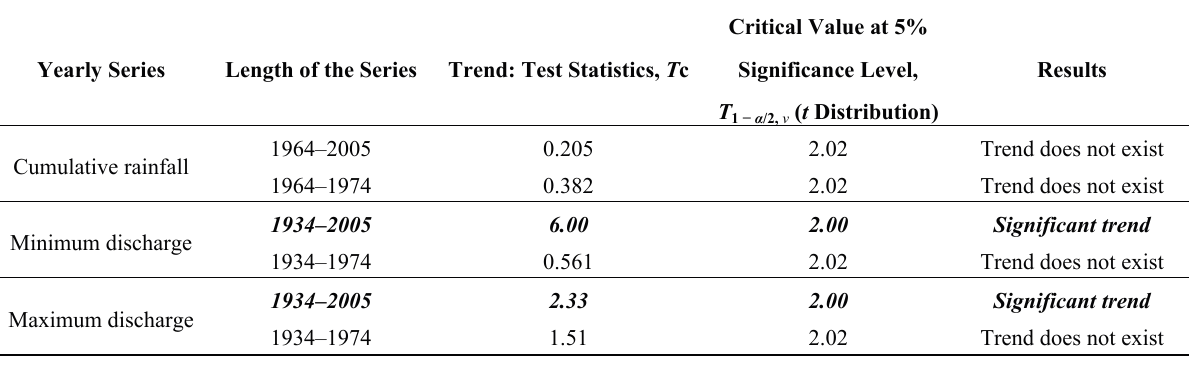
Table 1. The results of the trend analysis for the yearly discharge and rainfall